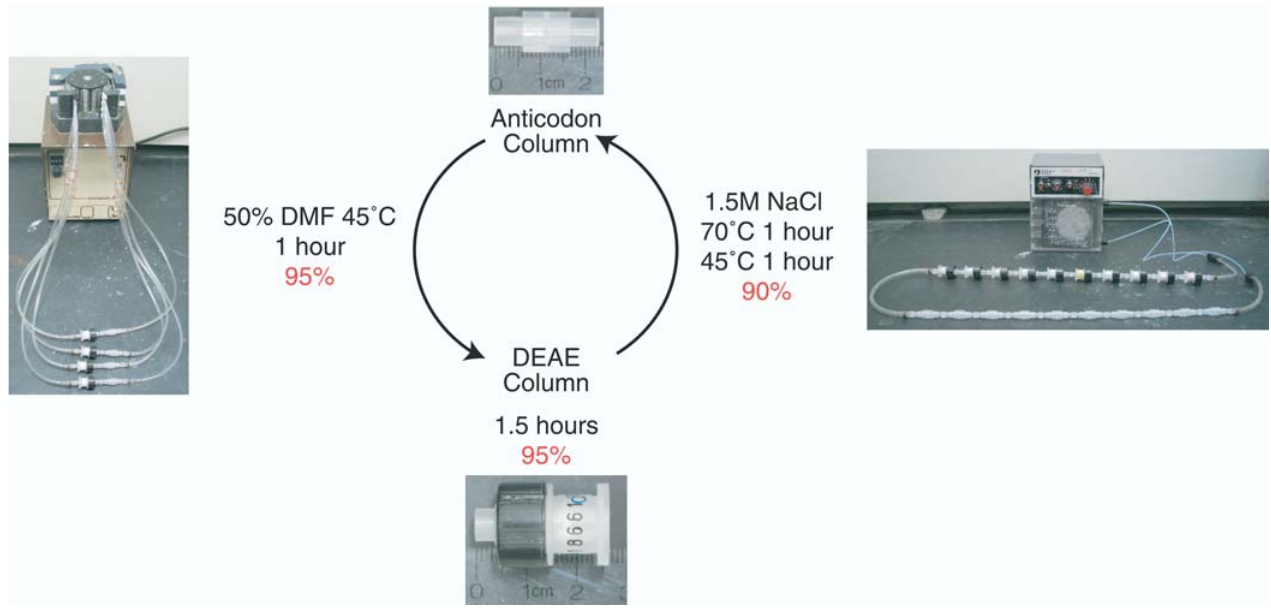
Figure 6. Reduction to Practice Chemical translation requires iteration of a chemistry step and two column-transfer steps. ssDNA is transferred from anticodon columns to DEAE Sepharose columns by cyclically pumping 50% DMF through a pair of columns (one hybridization, one DEAE) attached in series for 1 h at 45 8 C. Chemistry is performed on ssDNA bound to each DEAE column. ssDNA is transferred from DEAE columns to anticodon columns by cyclically pumping a 1.5-M NaCl buffer through all DEAE columns and all anticodon columns associated with the next coding position for 1 h at 70 8 C and 1 h at 46 8 C. Efficiencies for each step are indicated in red. DOI: